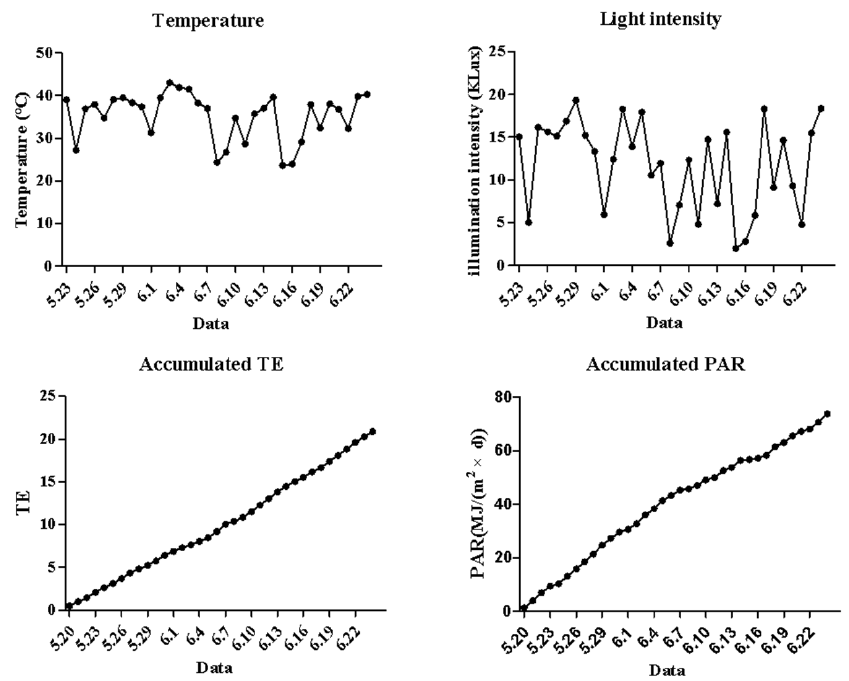
Figure 1. Changes in temperature and light intensity in the plastic tunnel.